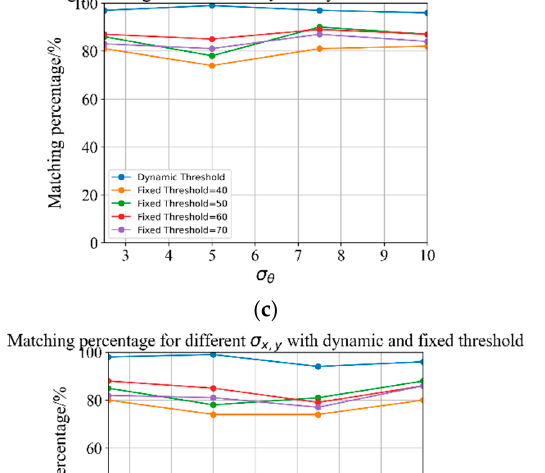
Figure 16. Matching rate and time consumed for different values of σ (cid:2911),(cid:2912) , σ (cid:2968) , and σ (cid:2934),(cid:2935) with different thresholds.